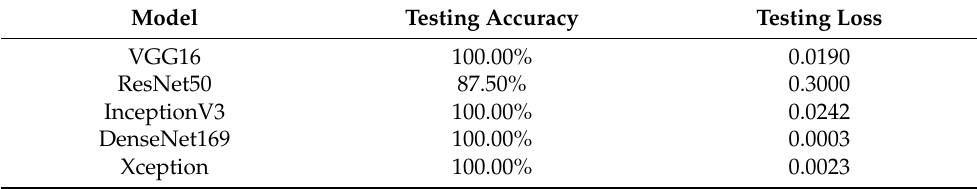
Table 5. Testing accuracies and testing loss when tile size of 1000 × 1000 pixels was used.